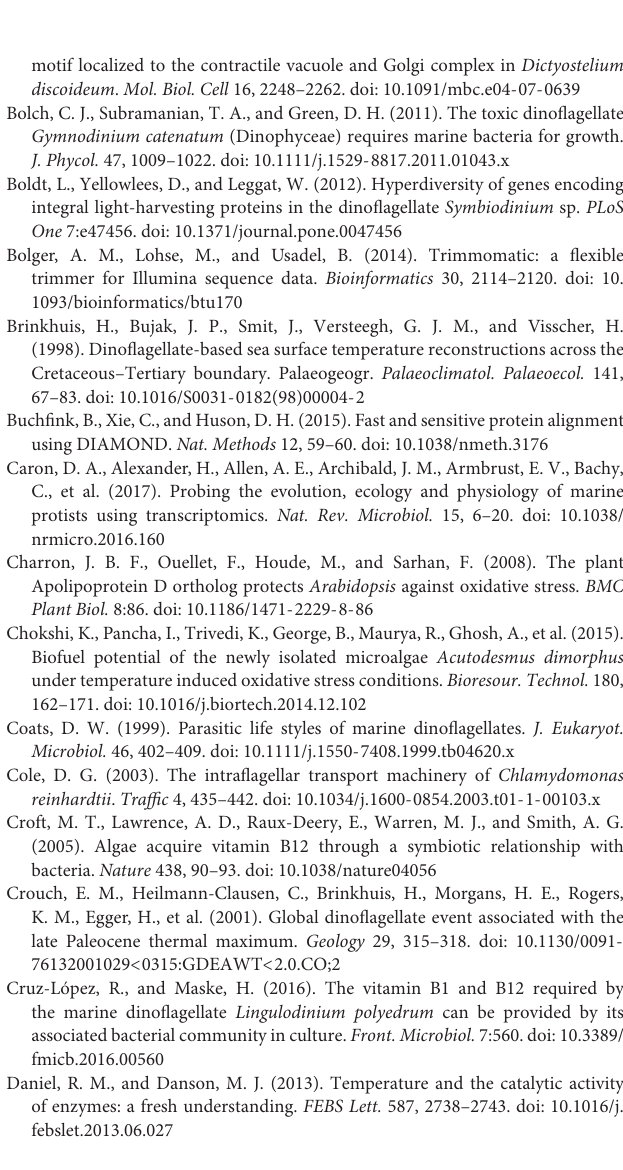
Supplementary Table 1 | Gene Ontology functional classification of differentially expressed genes of Biecheleriopsis adriatica under temperature stress conditions. Supplementary Data Sheet 1 | Analysis results when differentially expressed genes of Biecheleriopsis adriatica were obtained with |log2 fold change| ≥ 1 and adjusted p -value <